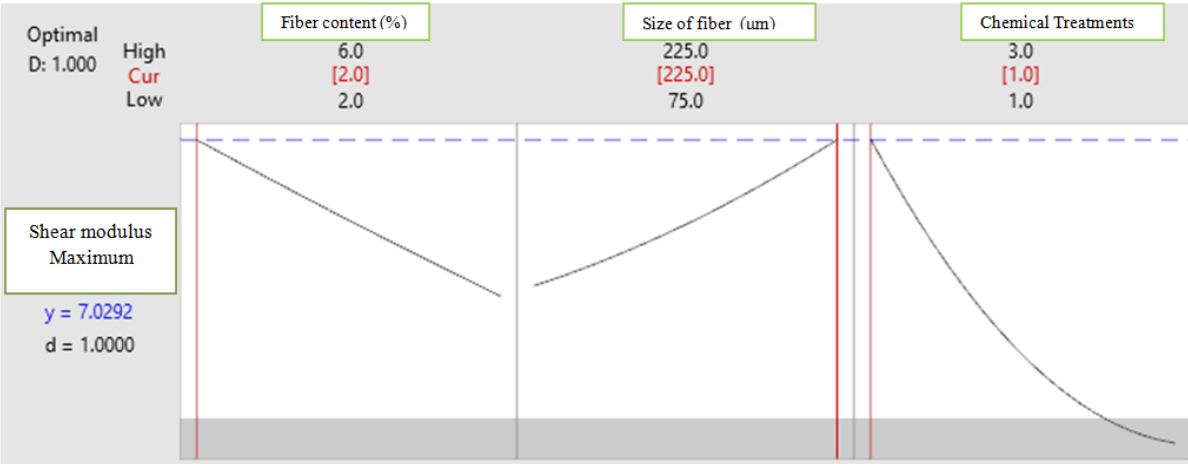
Figure 15. Response optimization plot for shear modulus confirmation test.